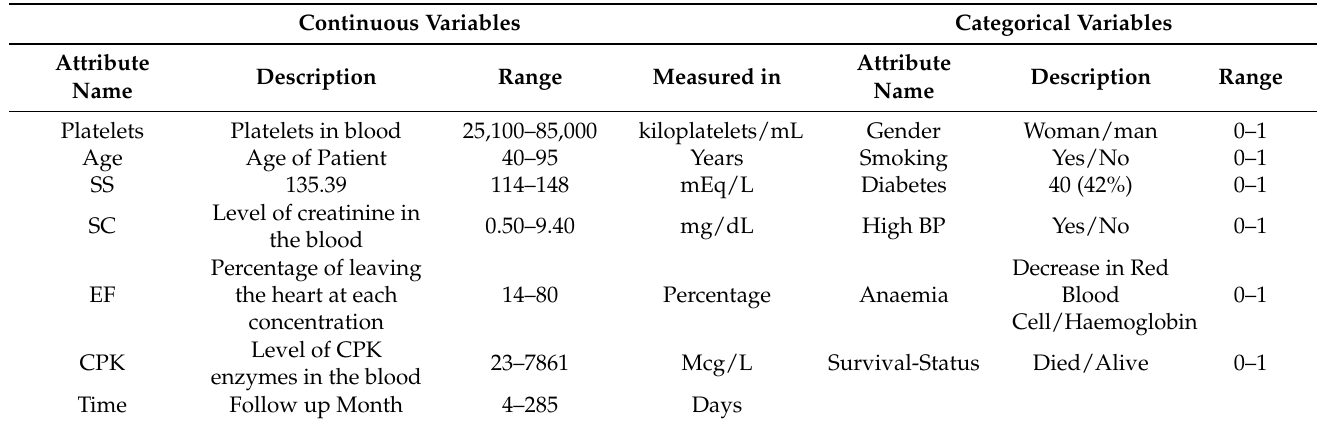
Table 2. Dataset